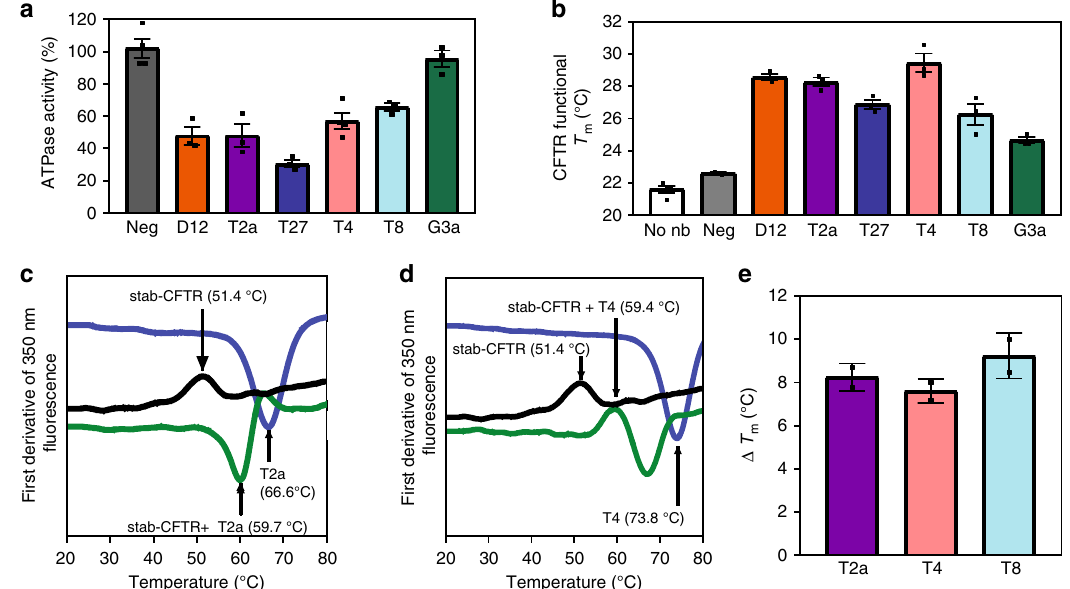
Fig. 5 Nanobodies reduce ATPase activity of CFTR but increase the temperature of thermal inactivation. a In fl uence of nanobody addition on ATPase activity of wt-CFTR. Conversion of α - 32 P-ATP to ADP was measured after 1 h incubation of wt-CFTR with the different nanobodies. Data from replicate determinations are represented as mean ± SEM ( n = 3, except for ATPase activity of wt-CFTR activity with nanobodies Neg and T4 for which n = 4). b Thermoprotection of wt-CFTR activity by nanobodies. Inactivation threshold temperatures were determined by measuring residual ATPase activity after 30 min heat challenge at various temperatures. Data from replicate determinations are represented as mean ± SEM ( n = 3, except for wt-CFTR activity in absence of nanobody for which n = 4). c Thermostability of stab-CFTR measured by nanoDSF. First derivative of 350 nm fl uorescence as a function of temperature showing the determination of Tm of puri fi ed stab-CFTR alone (black) or in complex with nanobody T2a (dark grey). Melting curve of nanobody T2a alone is depicted in light grey. One representative experiment shown. d Thermostability of stab-CFTR as in (c), in complex with nanobody T4 (dark grey). Melting curve of nanobody T4 alone is depicted in light grey. One representative experiment shown. e Summary of melting temperatures of stab-CFTR in complex with nanobodies T2a, T4 and T8 determined by nanoDSF. Data from triplicates are represented as mean ± SD ( n = 2). Source data are provided as a Source Data fi